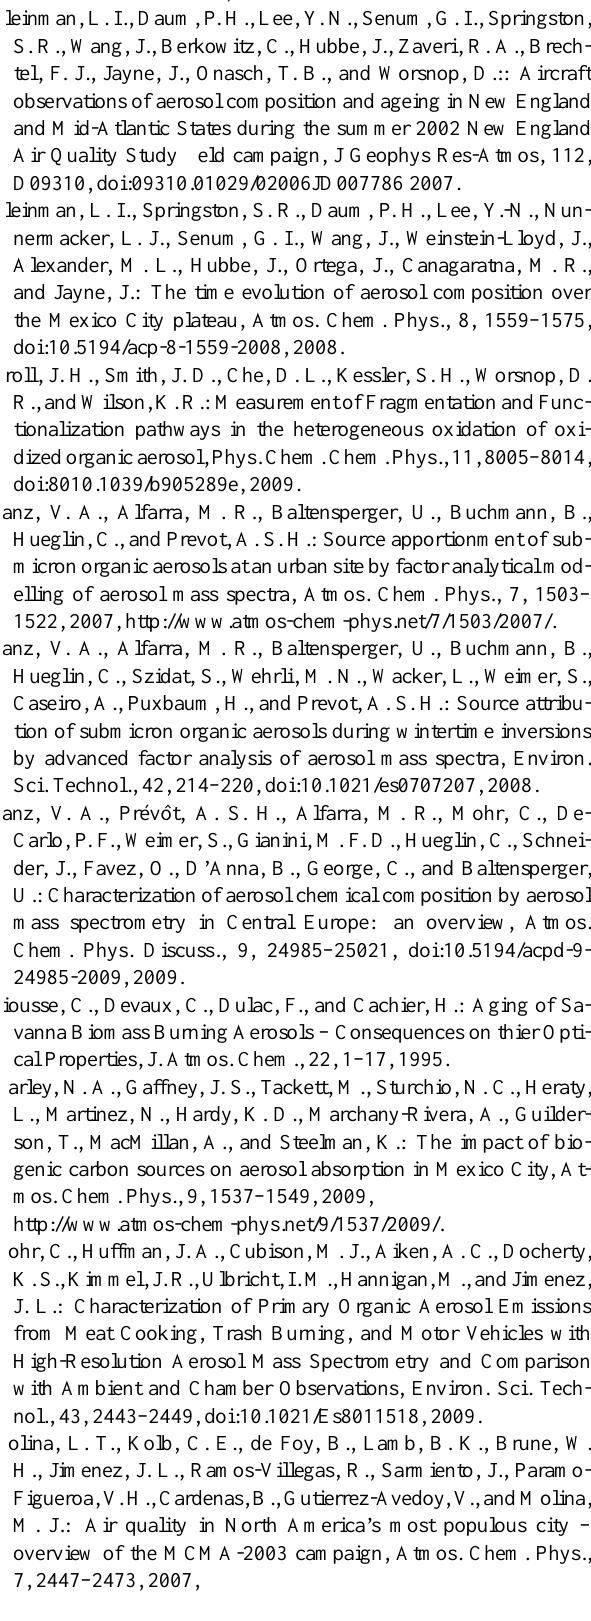
Figueroa, V. H., Cardenas, B., Gutierrez-Avedoy, V., and